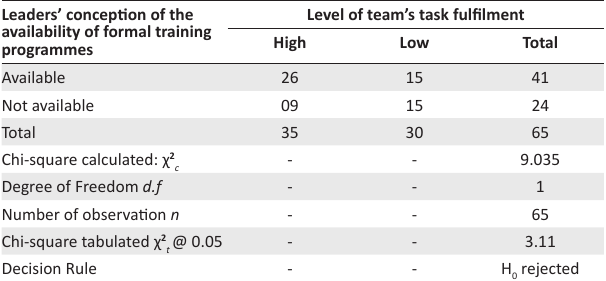
TABLE 4: Leaders’ conception of the availability of training programme and the team’s level of task